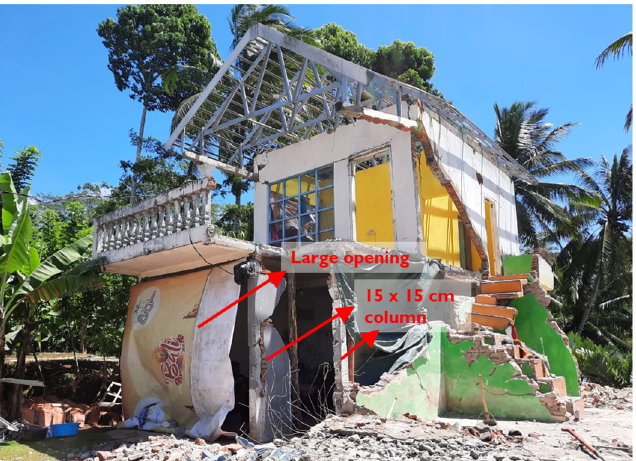
Figure 1. Heavy damage on a two-story confined masonry (CM) with a large opening and substand- ard RC frame.